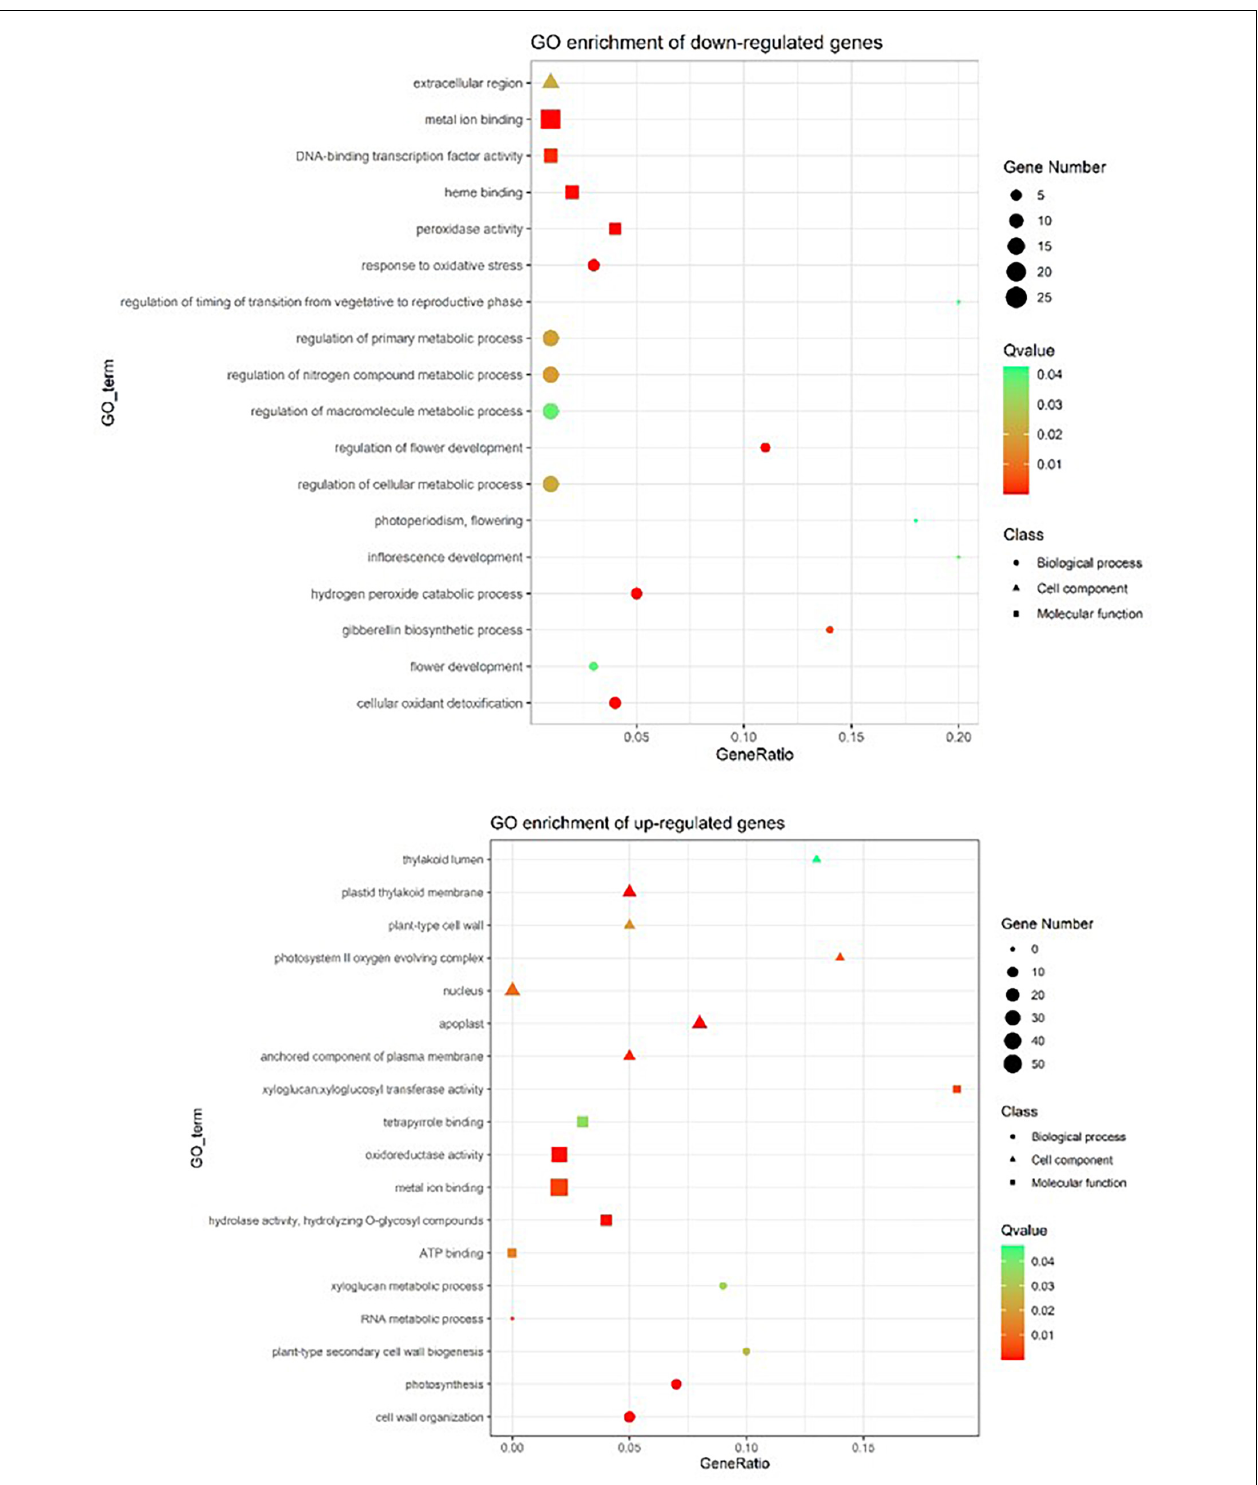
FIGURE 5 | GO enrichment of differentially expressed genes in the epigenetic gun4 mutant HYB as compared with its wild-type parent LTB, revealed by RNA-seq in 35 DAG leaves. Gene ontology (GO) enrichment was conducted according to PANTHER Overrepresentation Test (released 20210224) by using GO Ontology database (released 02/01/2021) using Oryza sativa database as a reference list. False Discovery Rate was applied for statistics. The ggplot2 was used to provide visualizations for enrichment results.